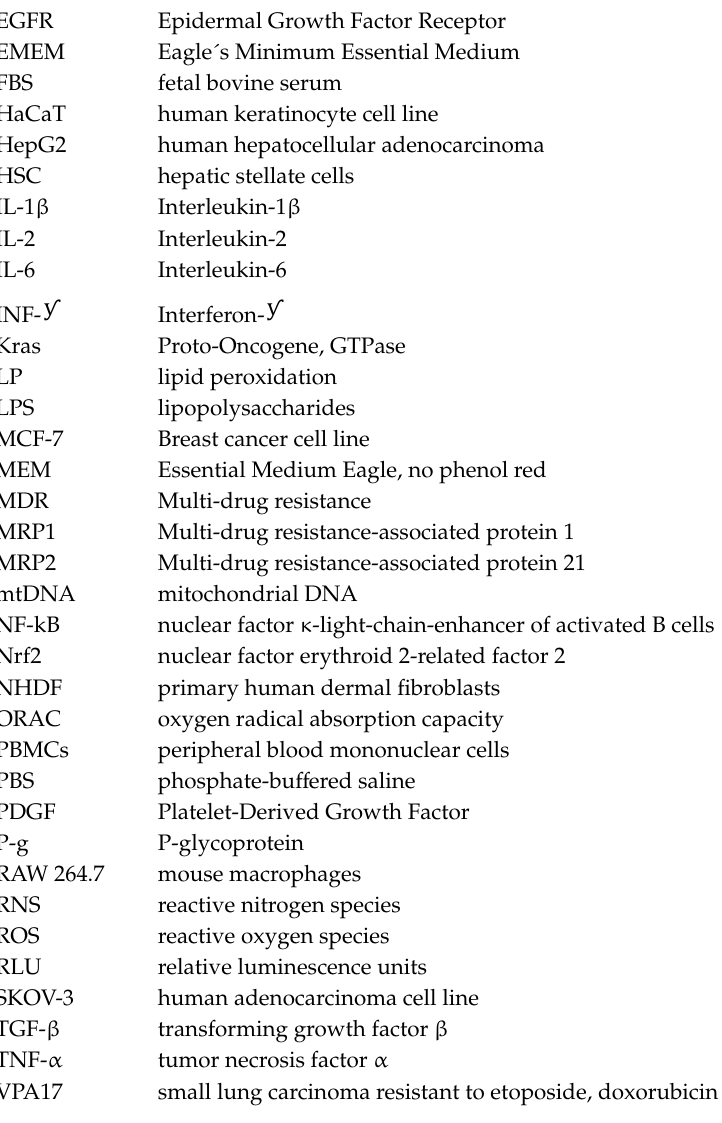
Figure 1. Structures of silybin diastereomers and 2,3-dehydrosilybin enantiomers, which occur in milk thistle.